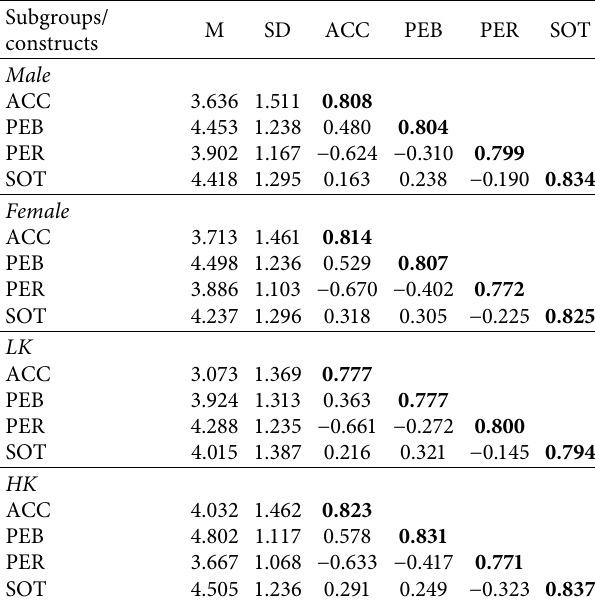
Table 9: Mean, standard deviation, and correlation matrix